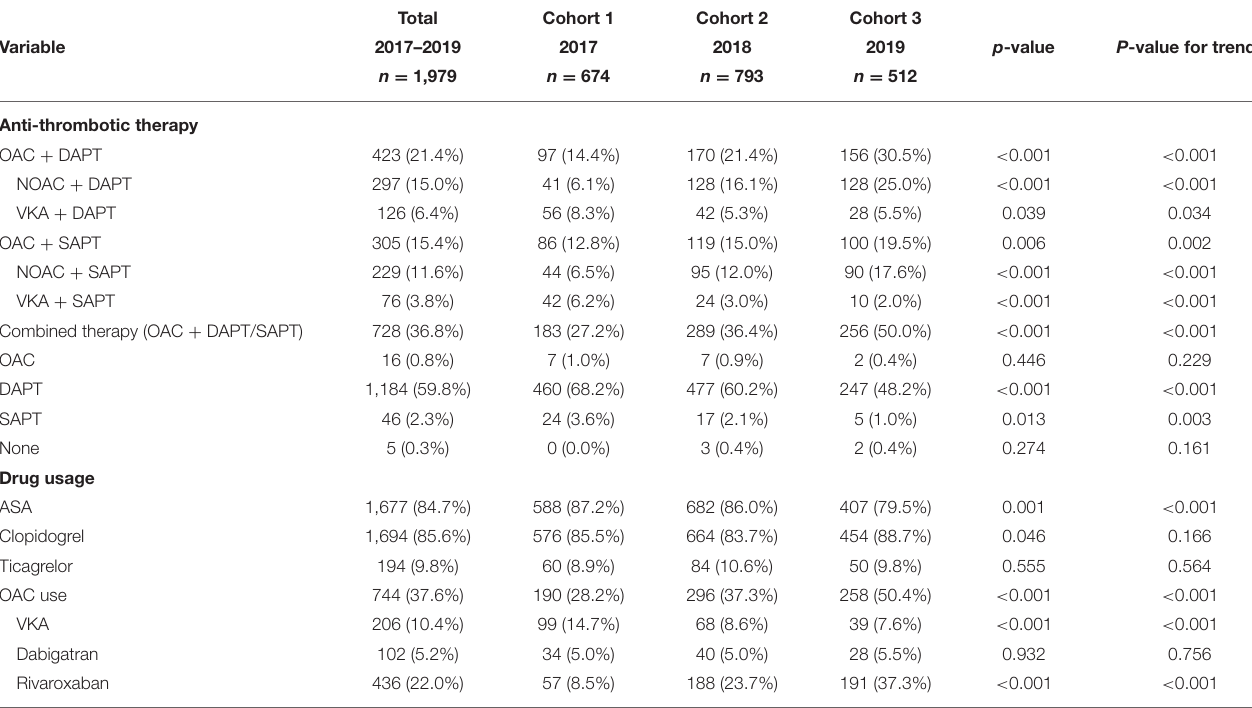
TABLE 2 | Trends of antithrombotic therapy and drug usage of patients with AF concomitant with ACS or underwent PCI.